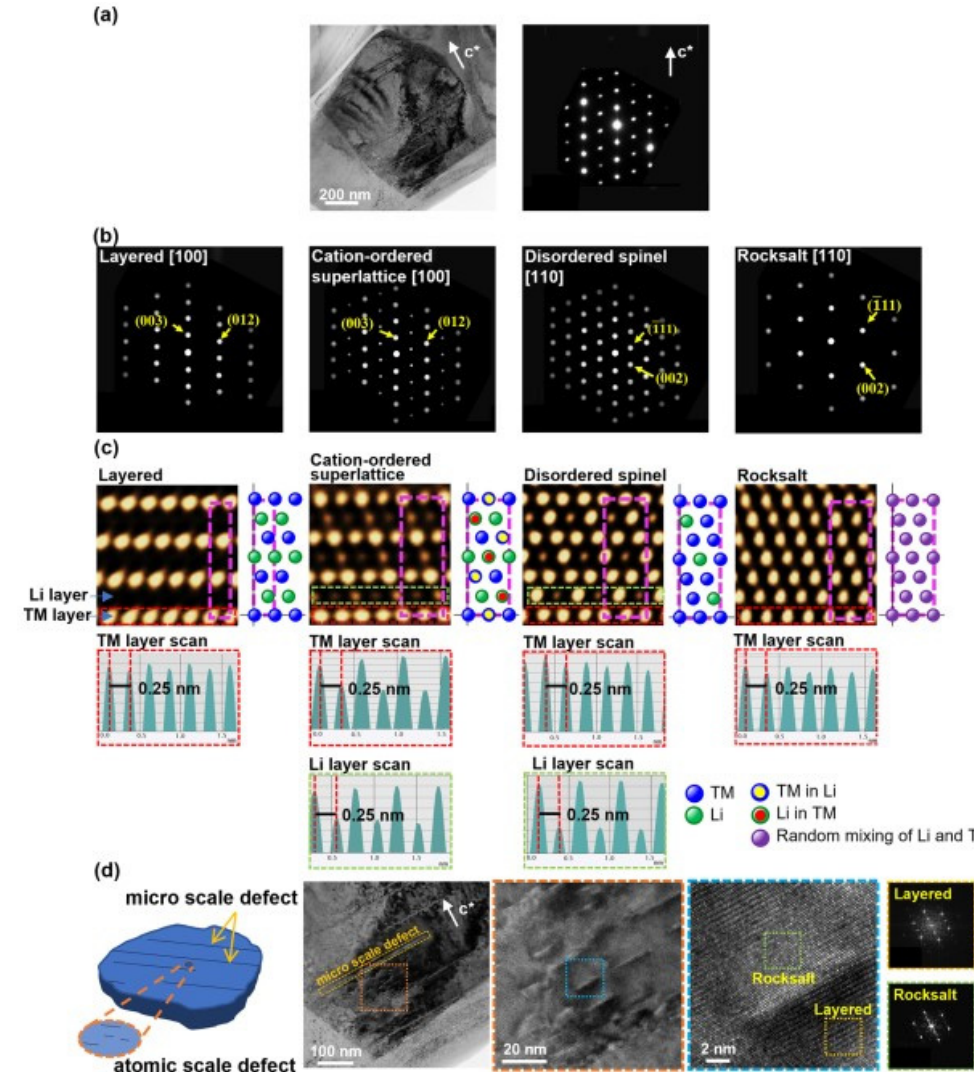
Figure 7. The phase transition issue of single-crystal NCM materials analysed by the group of Yang- Kook Sun, reproduced from Ref. [233]: ( a ) field image (the c* means the [100] direction), ( b ) SAED patterns, ( c ) Fourier-filtered images and diagrams of the corresponding structure, and ( d ) microscale and atomic-scale structural illustration, and TEM images of the SC-NCM90 0.1 C charged cathode. Copyright 2022, American Chemical Society.